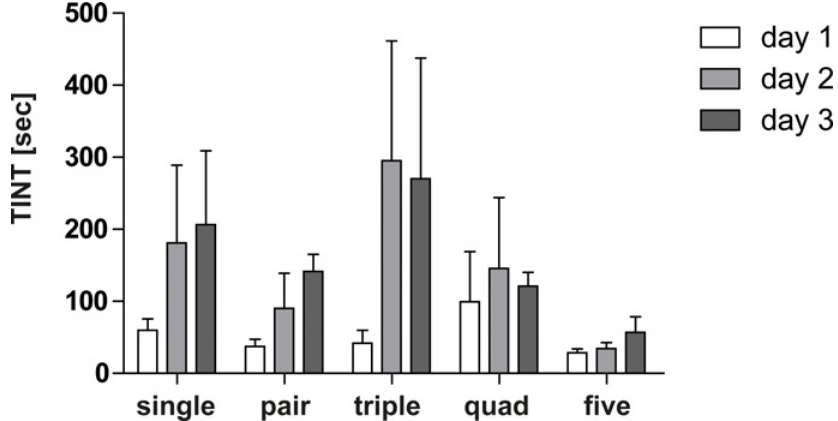
Fig 3. Group size effect on TINT reliance. TINT time intervals determined in untreated WT mice on three consecutive days. A group size of 4 to 5 mice per cage resulted in consistent time intervals.